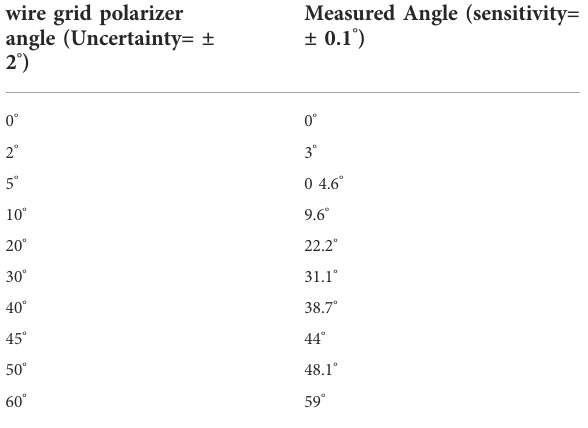
TABLE 1 Imposed vs. measured angles of the wire grid polarizer orientation. wire grid polarizer angle (Uncertainty= ± 2 °